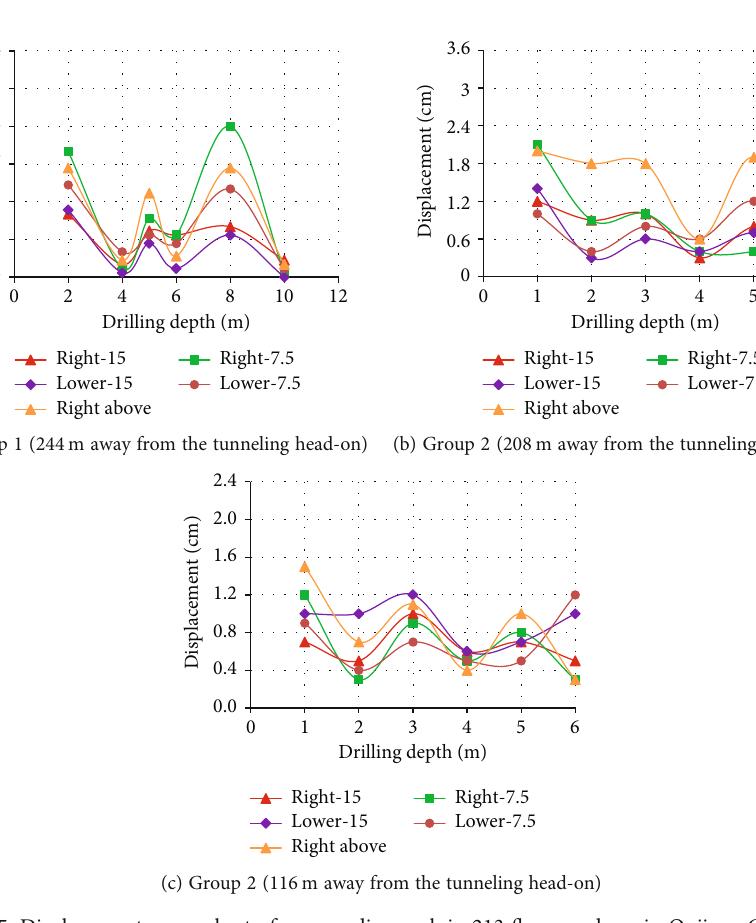
Figure 15: Displacement curve chart of surrounding rock in 213 fl oor roadway in Qujiang Coal